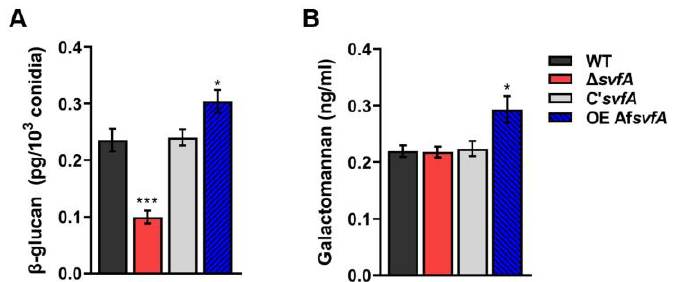
Figure 5. Role of SvfA in biosynthesis of conidia cell wall. ( A ) Amount of β -glucan (pg) per 10 3 conidia. N = 5 – 9. * p ˂ 0.05, *** p ˂ 0.001. (B) Concentration (ng/mL) of GM. Conidia were inoculated in modified Brian broth and incubated for 24 h at 37 °C. Extracellular GM content in the culture supernatant was assayed with ELISA. N = 8 – 14. * p ˂ 0.05.